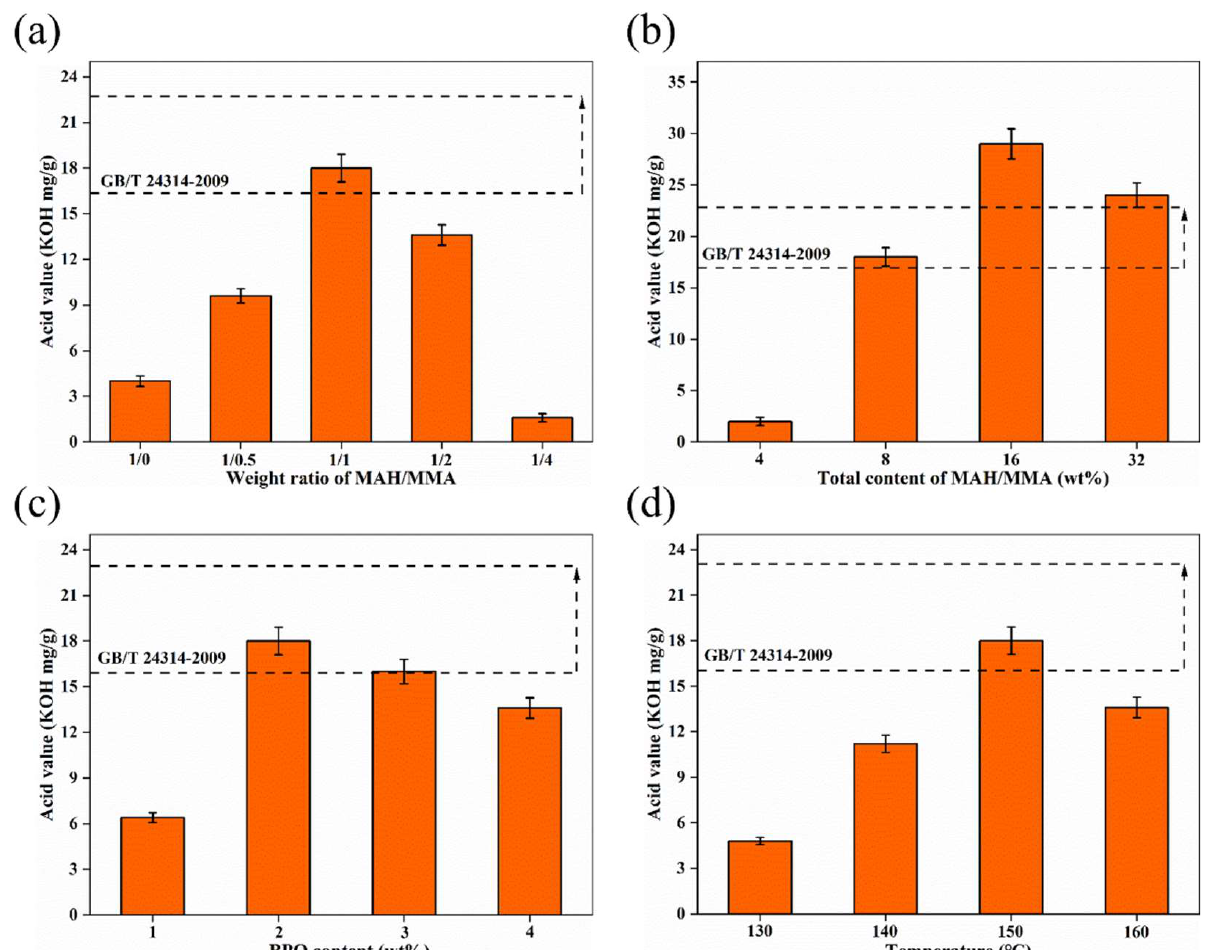
Figure 4. Effect of ( a ) weight ratio of MAH/MMA, ( b ) total content of MAH/MMA, ( c ) content of BPO, and ( d ) reaction temperature on the acid value of modified polyethylene wax.